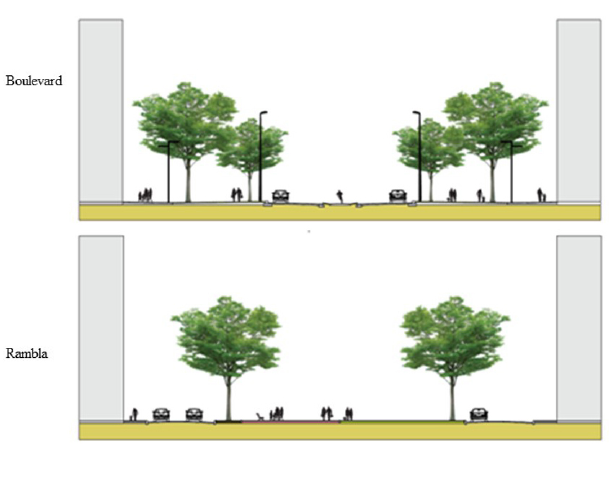
Fig. 1. Comparison of the two solutions considered in the case of Passeig de Sant Joan: a boulevard with cars in the center and pedestrians on both sides, and a rambla with pedestrians in the center and cars on both sides (Hoyos